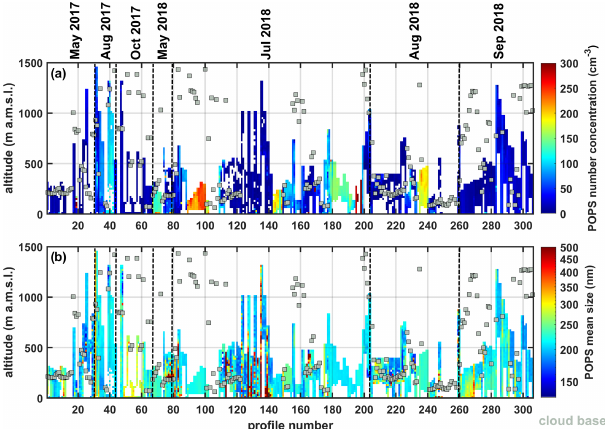
Figure 7. Seasonal breakdown of clouds, precipitation, and aerosol number concentration for the 282 profiles containing POPS data. (top) Average cloud altitude and percentage of profiles with pre- cipitation during all TBS flight profiles per season estimated from the ceilometer, KAZR, and PIP. POPS total number concentrations during the spring, summer, and fall for all TBS flight profiles sep- arated into measurements taken at the ground (20–40m), below- cloud (20m to average cloud base height), cloud base (the 40m layer below average cloud base height), in-cloud (average cloud base height to average cloud top height), and above-cloud (average cloud-top height to maximum altitude) regions averaged per pro- file. The numbers above the bars represent the ratio of that region’s concentrations to the ground concentrations (i.e., to the green bar). Error bars indicate 95% confidence